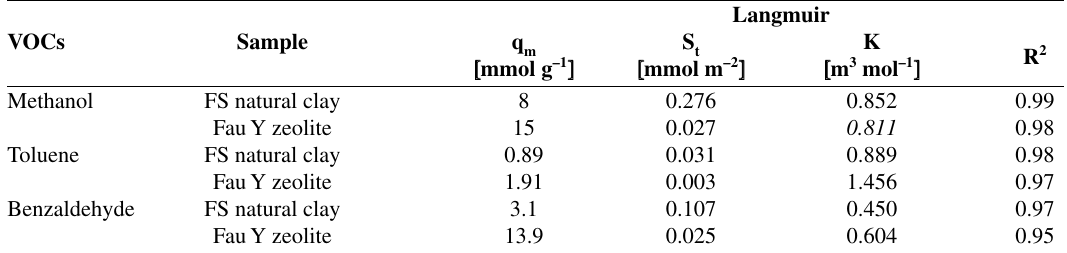
Table 4 . Adsorption equilibrium constants of adsorbed VOCs onto FS natural clay and Fau Y zeolite obtained by the Langmuir adsorption model at 300K.